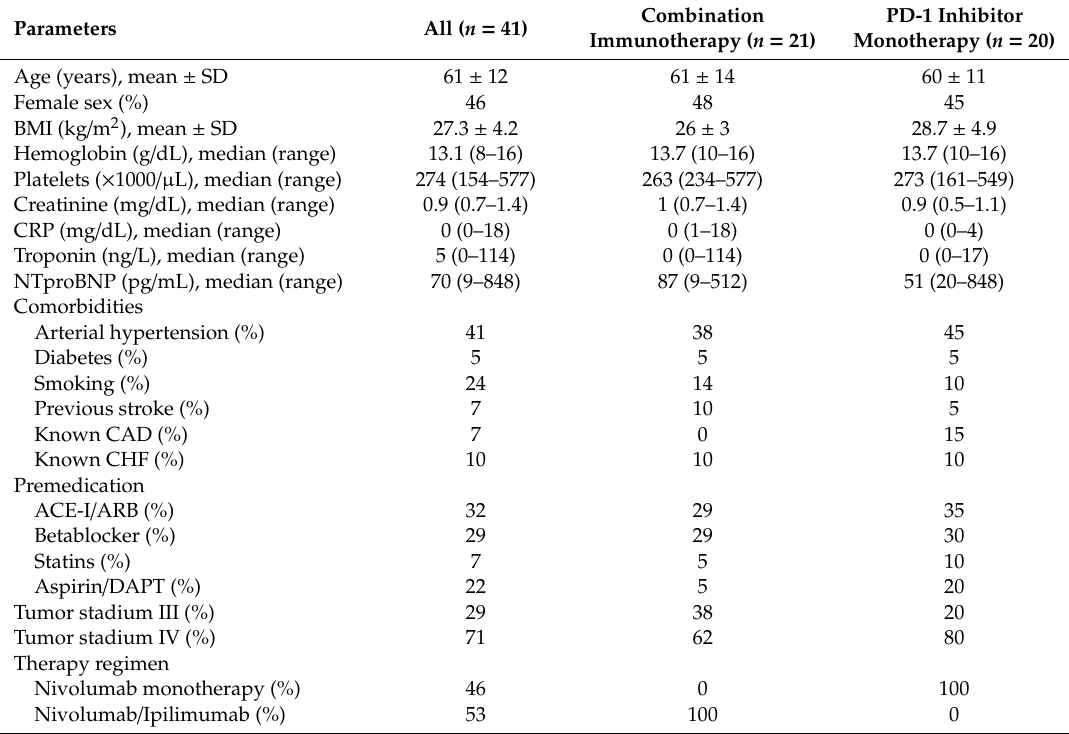
Table 1. Baseline characteristics.